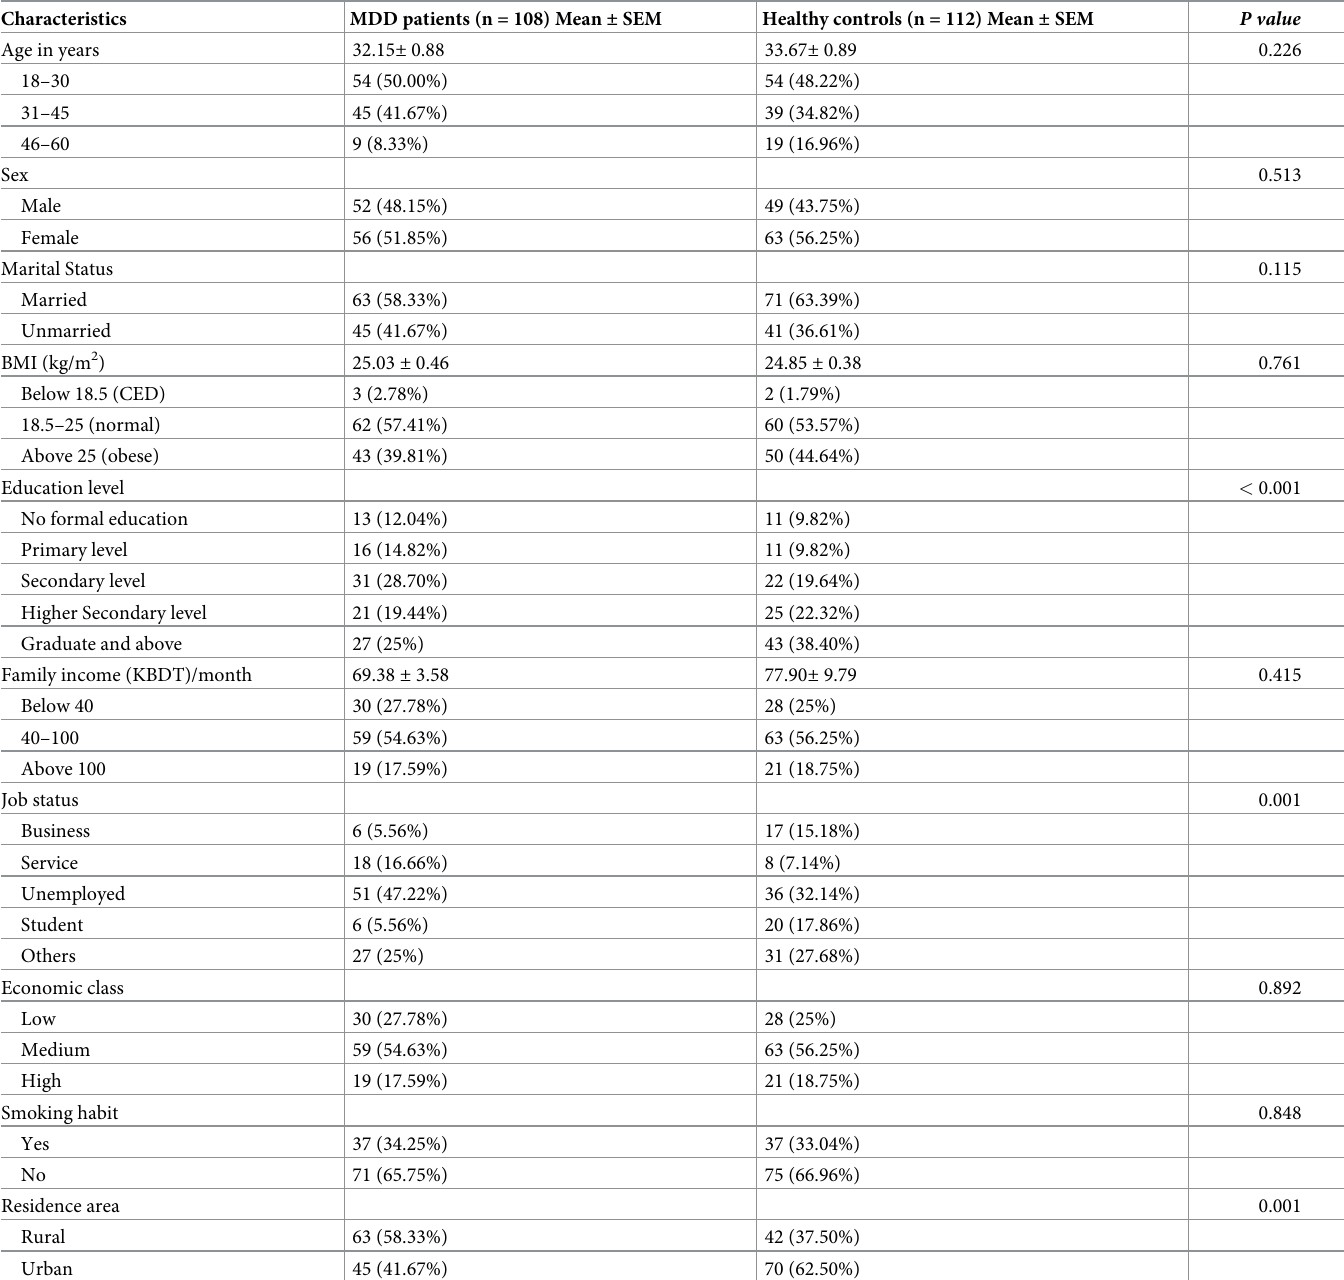
Table 1. Socio-demographic characteristics of the study population.